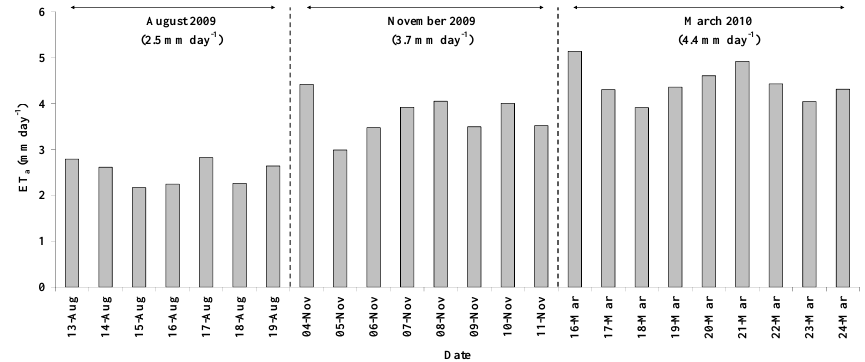
Figure 7. Daily actual total evaporation (ET a ) measured over the Nkazana Swamp Forest during three representative